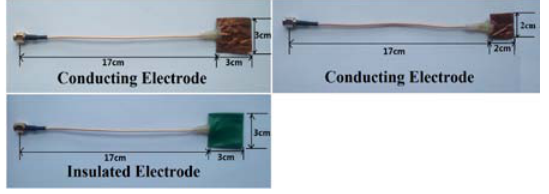
Figure 2. The pictures of electrode.